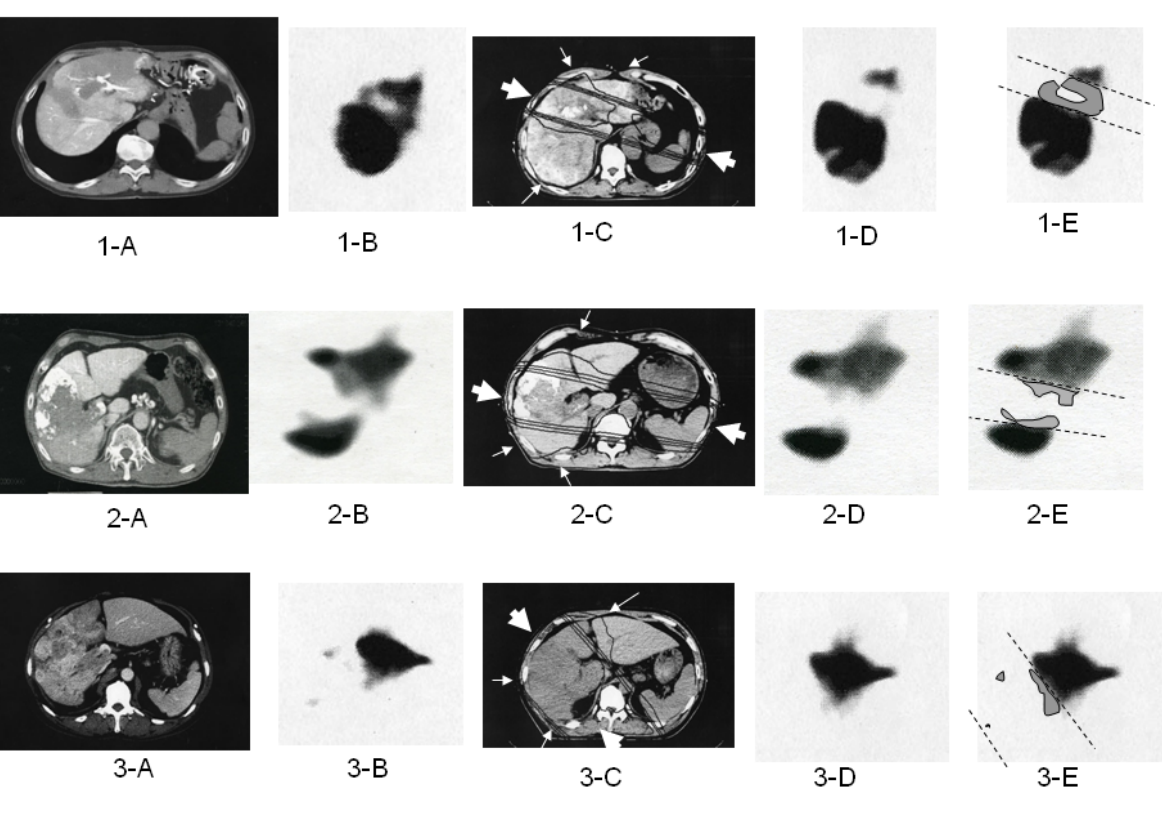
Figure 2. Computed tomography (CT; 1-A, 2-A, and 3-A) prior to three-dimensional conformal radiation treatment (3DCRT) in three cases of hepatocellular carcinoma associated with portal vein tumor thrombi. Subfigures 1-B, 2-B, and 3-B show single photon emission computed tomography (SPECT). Case 1 is classified as localized type because the filling defect is localized by a surrounding area of high accumulation; Case 2 is classified as wedge type because the area of radioisotope (RI) filling defect is in a wedge form that separates areas of high accumulation; and Case 3 is classified as extensive wedge type because the area of RI filling defect occupies almost a whole lobe. Subfigures 1-C, 2-C, and 3-C show four iso-dose lines from simulation CT during radiation planning (from innermost to outermost: 40, 30, 20, and 10 Gy). The large arrows indicate high-dose beams of 38.25 Gy; small arrows indicate low-dose beams of 6.75 Gy. Subfigures 1-D, 2-D, and 3-D show SPECT at 2 months after 3DCRT. New filling defect lesions are evident compared with Subfigures 1-B, 2-B, and 3-B; we termed these lesions radiation-induced dysfunctional liver (RIDFL). They are shown as gray areas on Subfigures 1-E, 2-E, and 3-E, and are located within the 20 Gy iso-dose